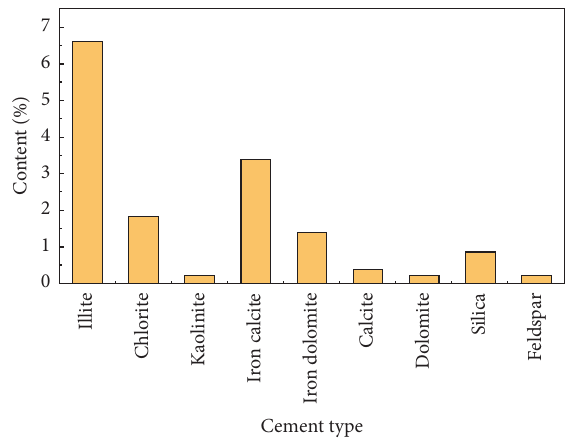
Figure 5: Types and contents of main cements of sandstone in long 6